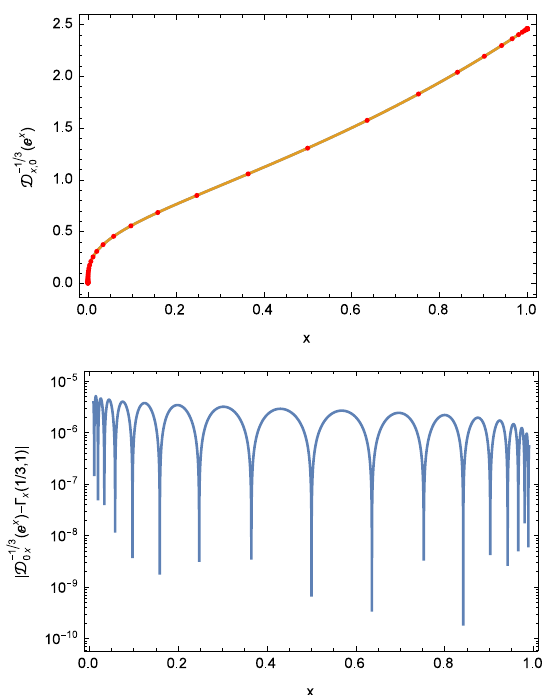
Figure 1. Riemann-Liouville integral of order (cid:23) = (cid:0) 1 = 3 of the function f ( x ) = e ax where a = 1 (top panel). Shown are also the locations of the Sinc points along the solution. The bottom panel shows the local error for N = 32 Sinc